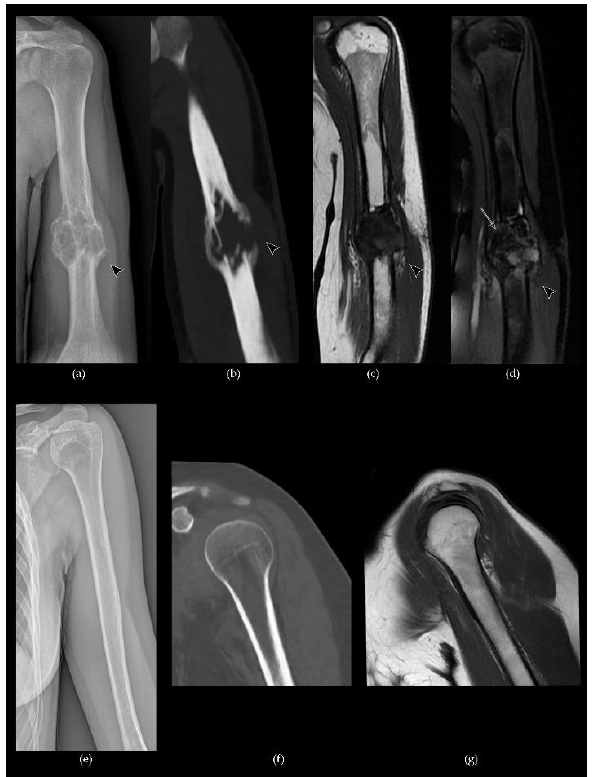
Figure 3. MRI appearance of hemosiderin deposits (arrows) in a case of GCTB of the left radial metaepiphysis ( a ). T2*-W GRE sequence demonstrates a markedly and distinctly hypointense area that appears more tenuously hypointense in a T2-W Fast Spin Echo (FSE) sequence ( b ). Intravenous gadolinium administration usually shows heterogeneous enhancement of the lesion and permits the differentiation between the cystic and solid components, enabling a proper differential diagnosis with a primary aneurismal bone cyst [63]. MRI is also the method of choice to demonstrate tumor extension to the adjacent joint and soft tissue and serves as a pre-biopsy assessment to identify and demarcate the intralesional solid component [61] (Figures 4 and 5).